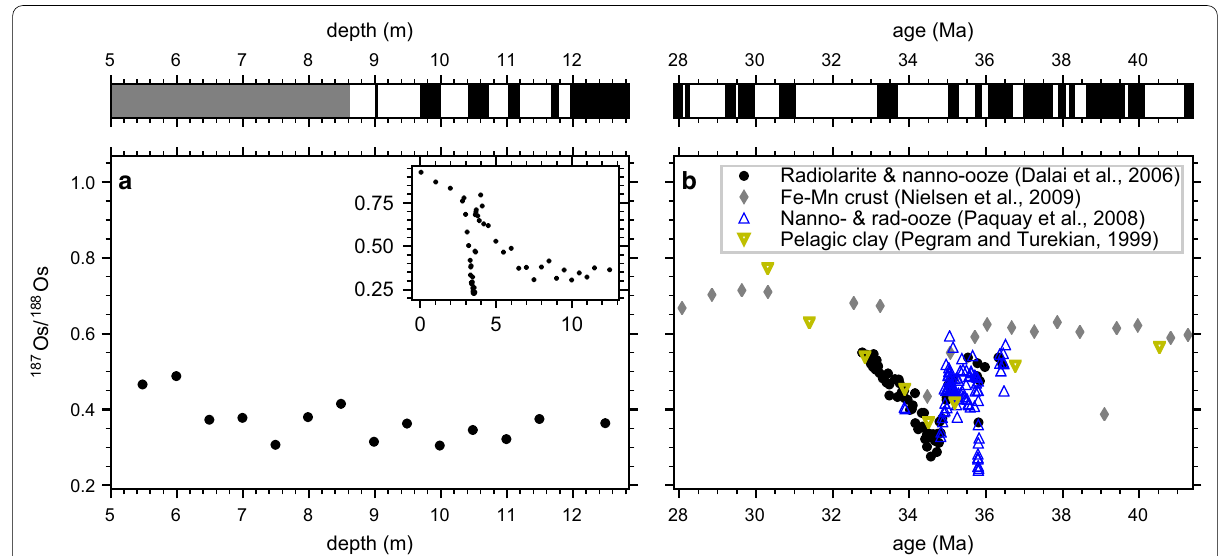
Fig. 5 Comparisons of magnetostratigraphy and 187 Os/ 188 Os records. a Depth variation of 187 Os/ 188 Os (Nozaki et al. 2019) together with inferred polarity zones of MR14-E02 PC11 for 5–12 m (Fig. 1). The inset is the 187 Os/ 188 Os for the entire core. A negative excursion at ~ 3.5 m was interpreted as a Miocene impact event (Nozaki et al. 2019). b Seawater 187 Os/ 188 Os data for 28–41 Ma together with the geomagnetic polarity time scale (Ogg 2012). The 187 Os/ 188 Os data are from ferromanganese crust (gray diamonds; Nielsen et al. 2009), pelagic clay (yellow open inverted triangles; Pegram and Turekian 1999), radiolarite and nannofossil ooze (filled circles; Dalai et al. 2006), and nannofossil and radiolarian ooze (open blue triangles; Paquay et al. 2008). The chronology of ferromanganese crust was based on the 187 Os/ 188 Os correlation to ~ 11–12 Ma, ~ 34.4 Ma, and ~ 55.5 Ma and linear interpolation between them with some adjustments. The chronology of pelagic clay is based on constant a Co flux model which may have 5–10 Myr offset in this interval (Kyte et al.